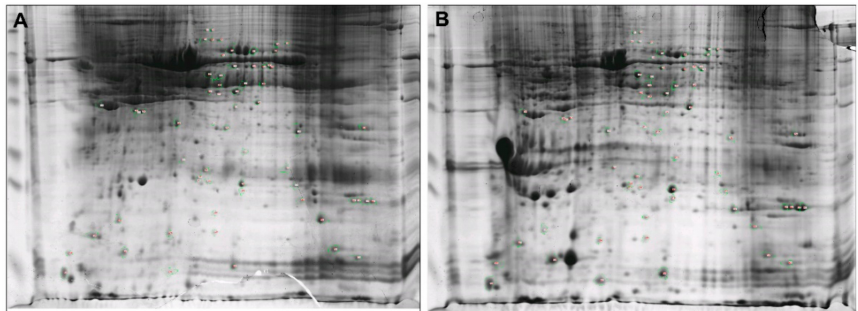
Figure 2. Representative 2-DE gels of mammary tissues from healthy mammary tissues (HMTs) and mammary tissues with clinical mastitis (CMMTs) groups. ( A ) HMTs group; ( B ) CMMTs group. 600 µ g proteins were separated on pH 3–10 IPG nonlinear strips and on 12% sodium dodecyl sulfate-polyacrylamide gel electrophoresis (SDS-PAGE).